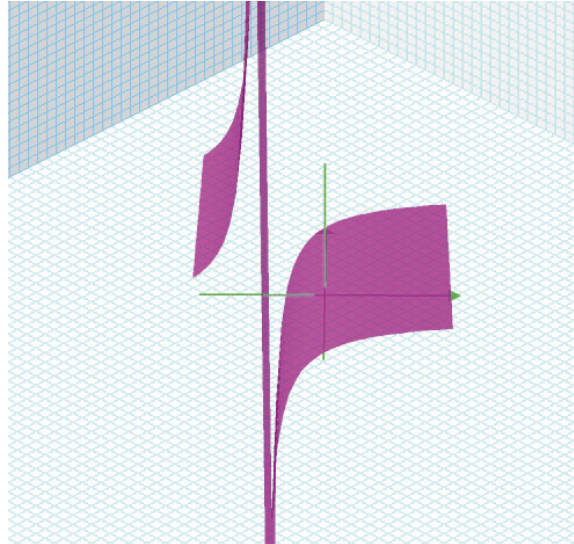
Figure 9: Plot of 𝑇𝑢(𝑡) represented by (81).